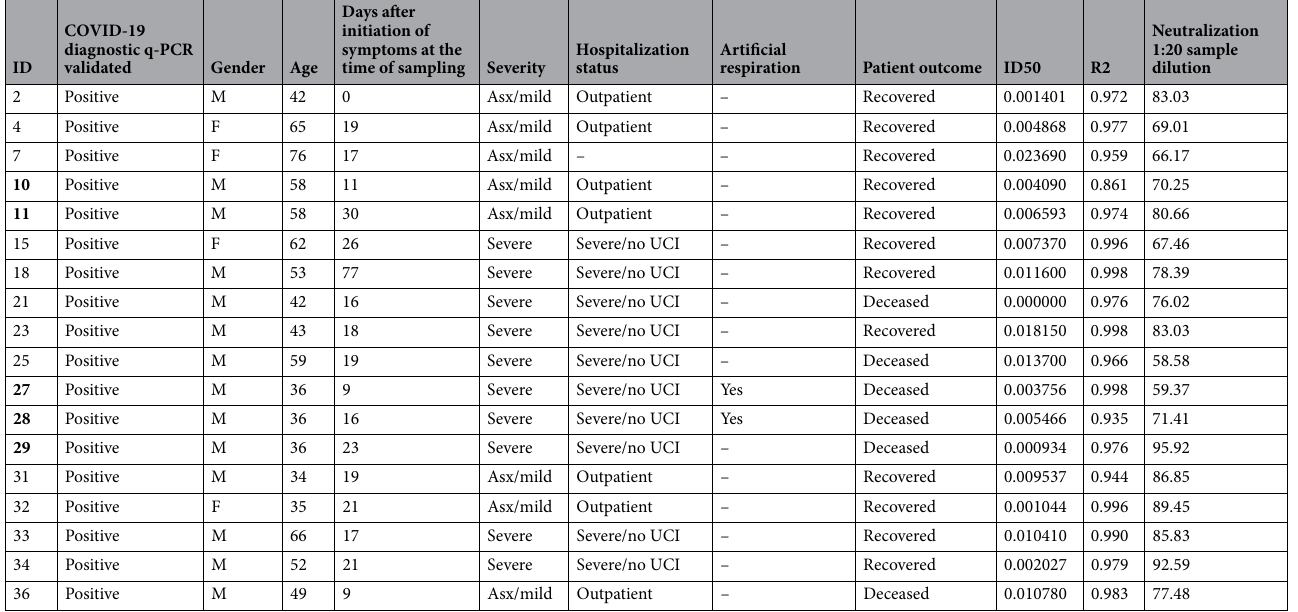
Table 1. Clinical parameters and neutralization information from COVID-19 convalescent sera. Asx: asymptomatic. Text in bold represent longitudinal samples from same patients (patient male 58 year-old,